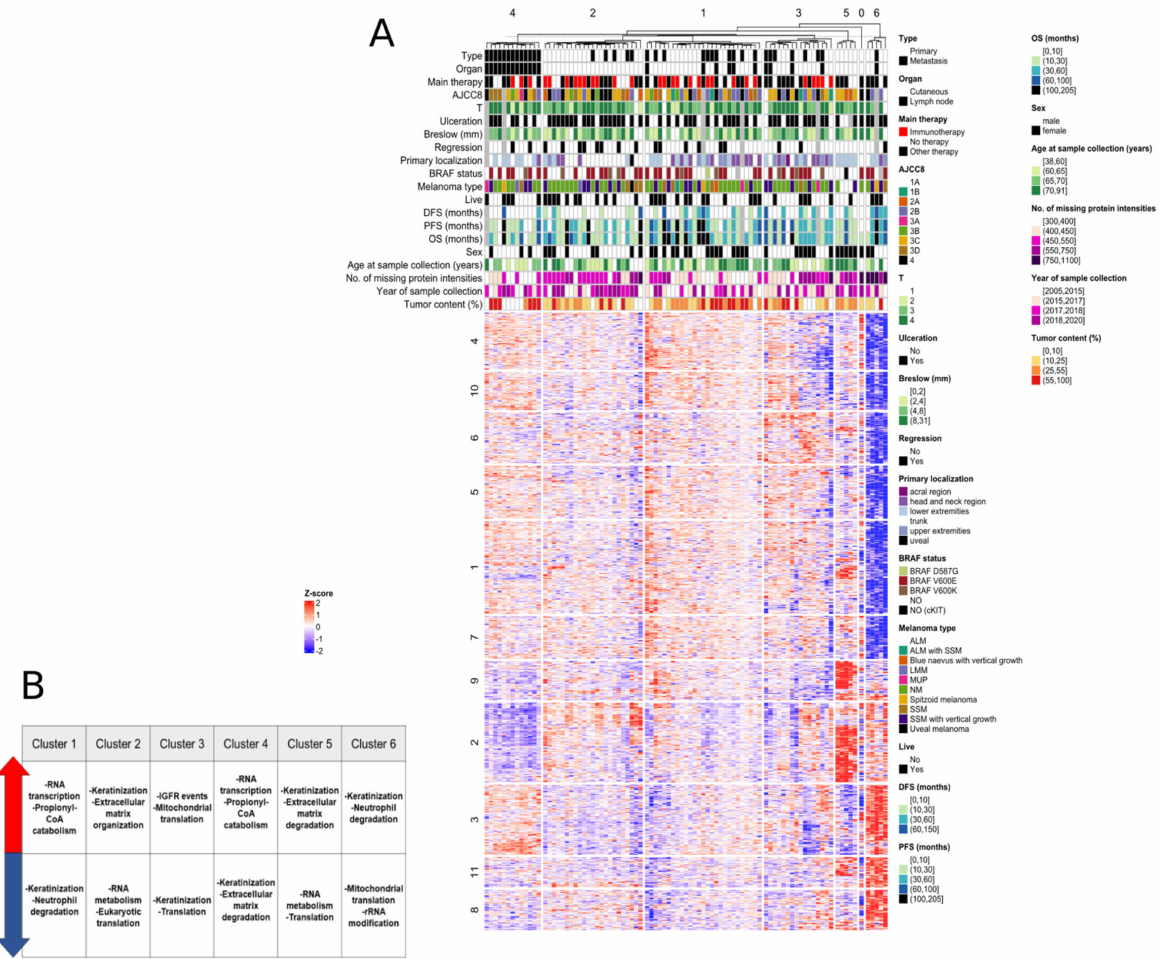
Figure 3. The protein expression patterns in the sample clusters. ( A ) The heatmap of the six detected sample clusters with the clinicopathologic data and the protein expression pattern (top 1000 most variable proteins, ANOVA FDR < 1.05 × 10 − 4 ). ( B ) The main biological functions linked to the sample clusters. DFS—disease free survival, PFS—progression-free survival and OS—overall survival. Clinical stage based on AJCC8. SSM—superficial spreading melanoma, LMM—lentigo maligna melanoma, NM—nodular melanoma, ALM—acrolentiginous